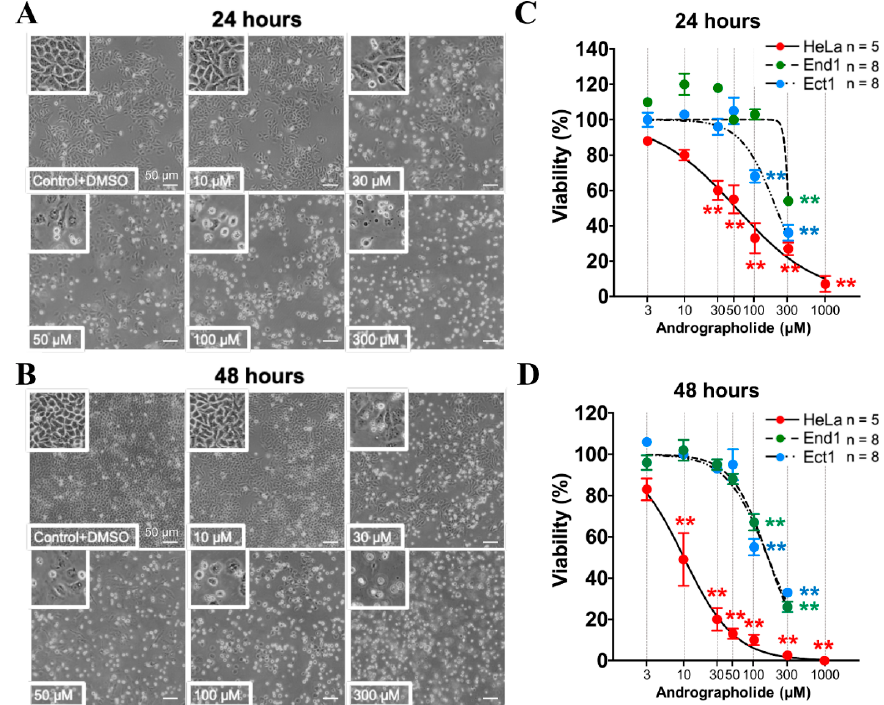
Figure 5. Effect of chronic treatment of Andrographolide (3–300 μ M) on cell viability in HeLa cells, End1 cells, and Ect1 cells. ( A , B ) The notes at the bottom of cells show the condition of cell viability in experiments, and the bars at the right bottom of the cells show the scale of the length of picture (50 μ m). The top left picture of A and B shows a typical picture of cell viability under normal culture medium with the solvent of DMSO (Dimethyl sulfoxide) (0.1%) as control for 24 and 48 h, respectively. The other picture of A and B shows a picture of cell viability after chronic treatment of Andrographolide in different concentrations, i.e., 10, 30, 50, 100, and 300 μ M, in HeLa cells for 24 and 48 h, respectively. ( C , D ) The concentration response curves show the normalization of cell viability of various concentrations of Andrographolide in HeLa cells, End1 cells, and Ect1 cells that averaged in several experiments similar to that shown in A,B. The ** p < 0.005 versus the control . Error bars represent the mean ± SEM (standard error mean).